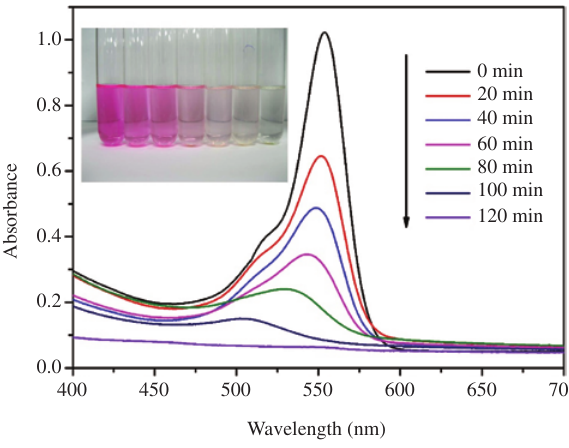
Figure 10: Temporal evolution of the absorption spectrum of the RhB solution of rGO-BWO for R tion (inset: digital photo of the sample for a different irradiation